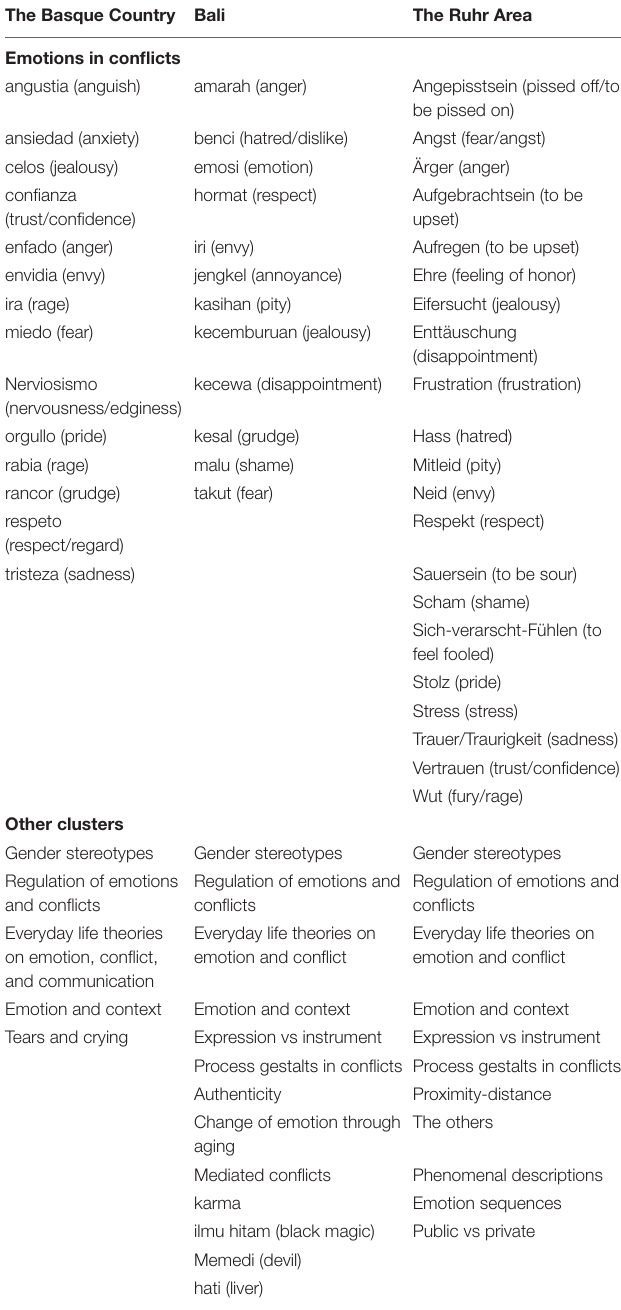
TABLE 3 | Theme clusters from each field (with approximate translations of the emotion